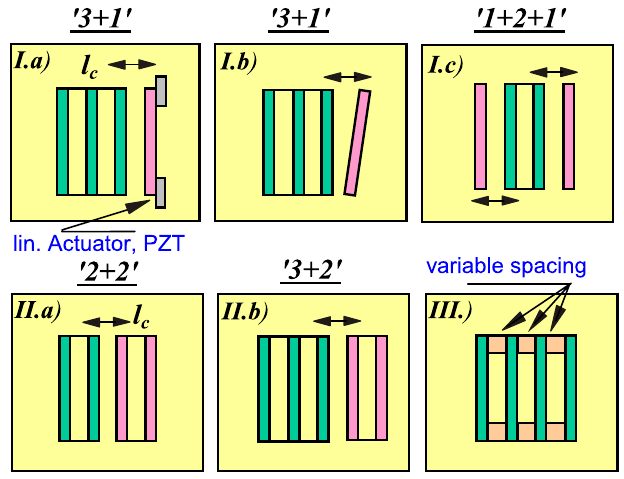
FIG. 3. (Color) Dynamic reflectivity/transmission tuning